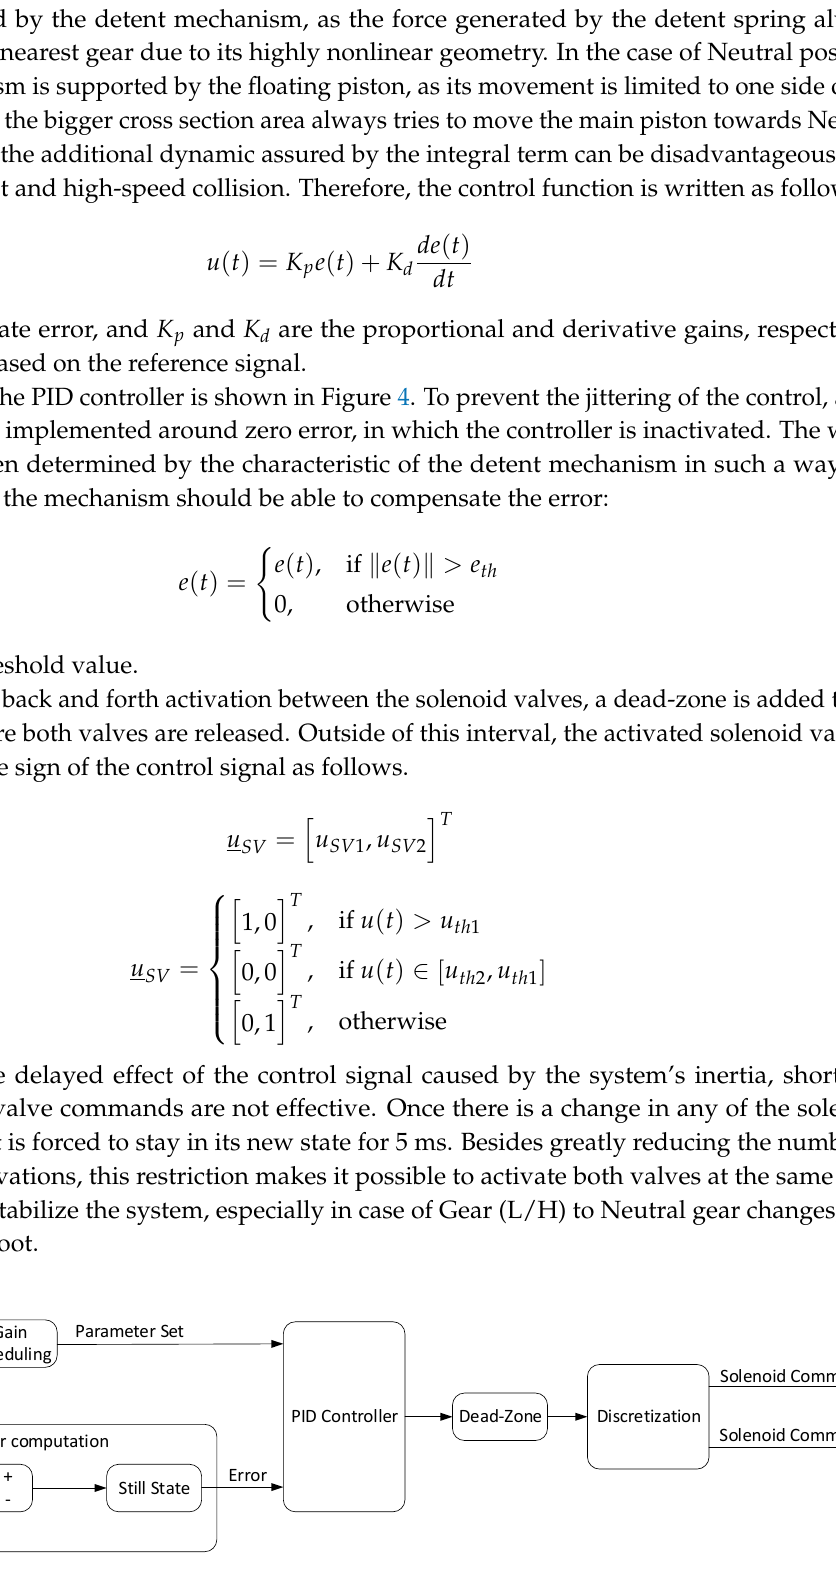
Figure 4. Layout of the Proportional-Integral-Derivative (PID)